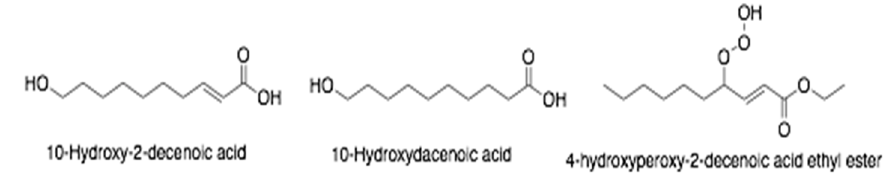
Figure 7. The main fatty acids of royal jelly.